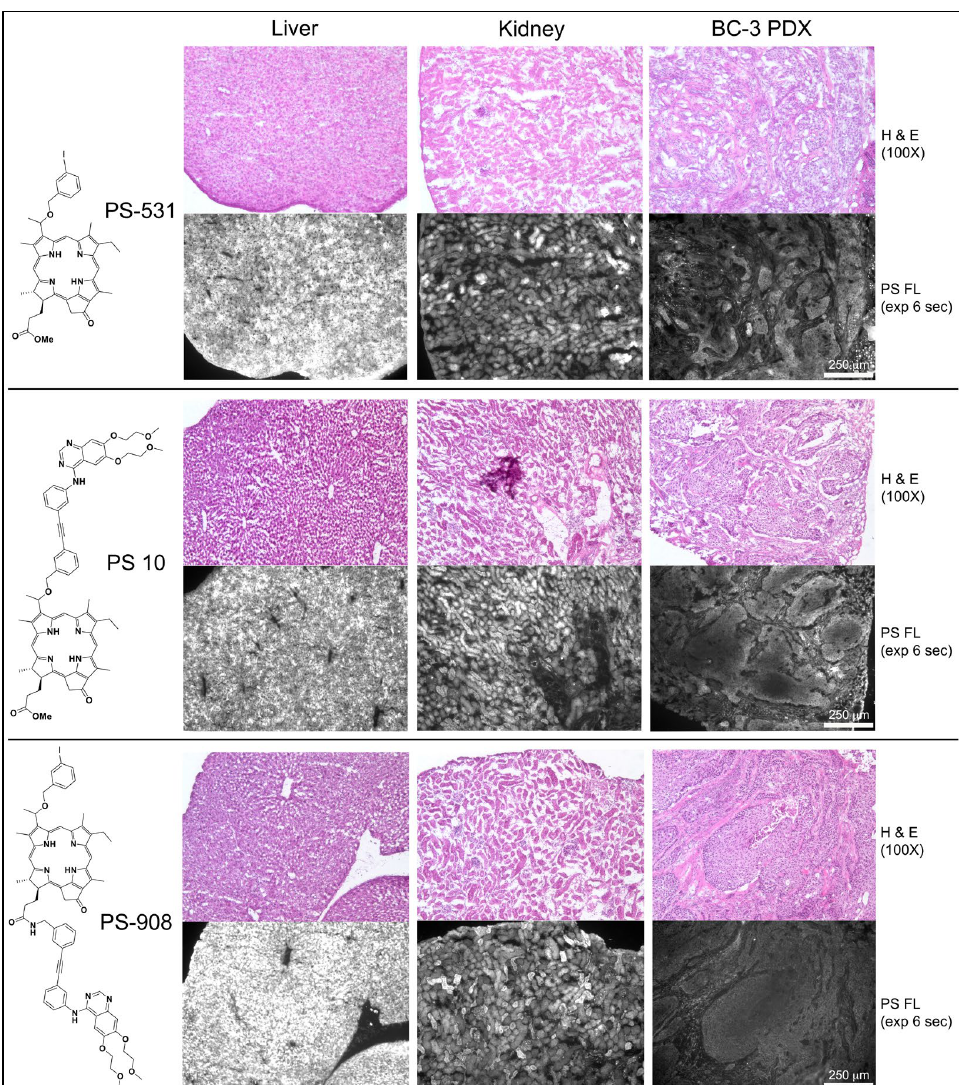
Figure 8. In vivo distribution and localization of PS in bladder cancer PDX bearing mice. NSG mice bearing patient-derived bladder cancer (BC-3) xenografts received an intravenous injection of PSs (3 μmol/kg) and organs were collected 24 h later. Cryosections (10 μm) were imaged for PS fluorescence and compared to the H&E-stained histology.